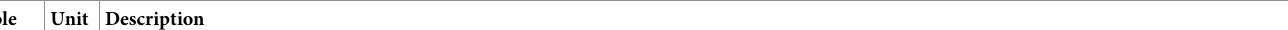
medium to high values (grey to light grey areas), low red-green contrast values (dark grey pat- terns) and missing blue-yellow contrasts as well as no values for faces (black), such a hotspot received a value of 50 for edges, 40 for intensity, 5 for red-green color contrast and 0 for blue- yellow color contrast and faces (see S2 Fig, hotspot no. 3). For each photograph, these values were averaged over all existing hotspots.